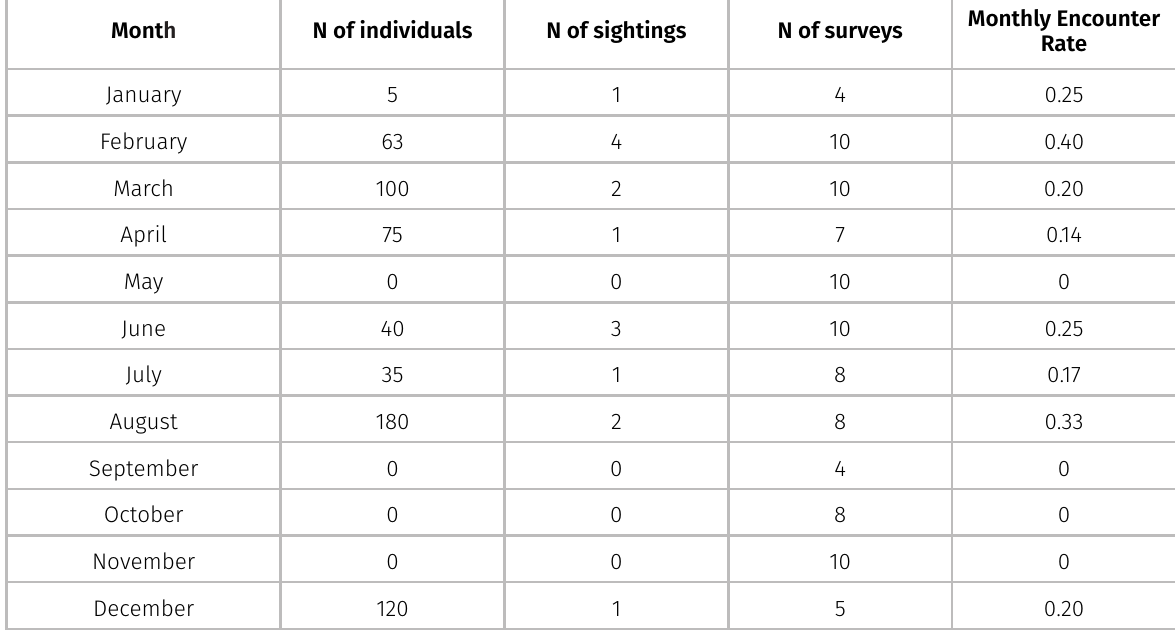
Table I. Summary of common bottlenose dolphins occurrence, Tursiops truncatus truncatus in Cabo Frio coast, Rio de Janeiro, Brazil, showed in months for December 2010 to November 2012 and February to August 2014 period. Monthly Encounter Rate = Number of sightings in a given month/number of boat trips undertaken in the same given